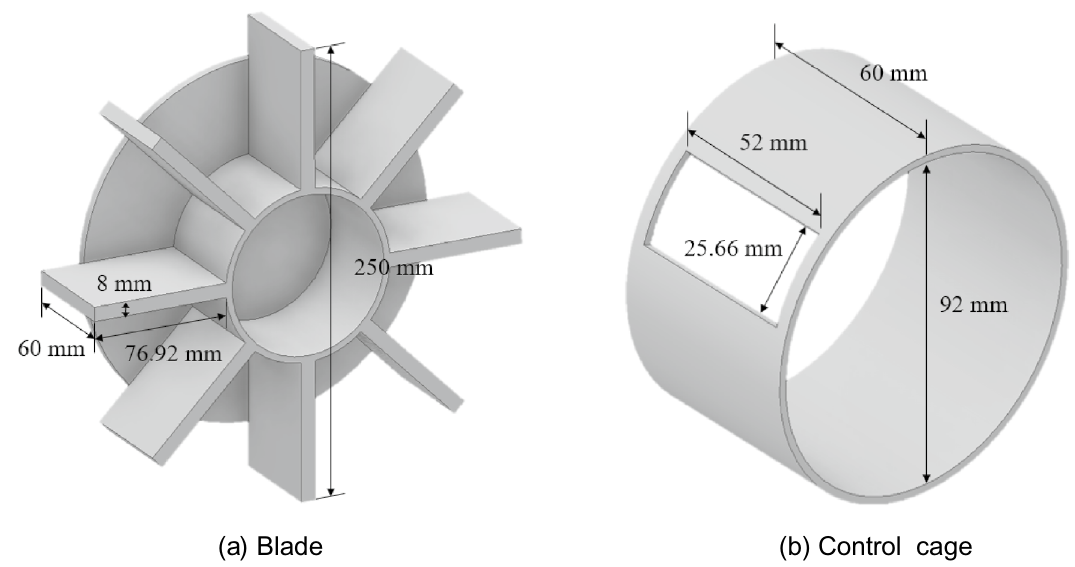
Figure 2. Size of impeller-type shot blaster (Inventor 2021, https:// www. autod esk. com/ produ cts/ inven